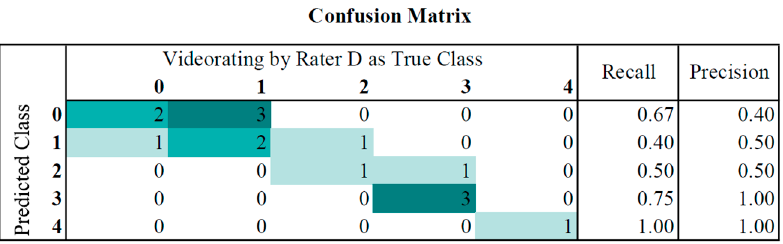
Figure 4. Confusion matrix of the implemented classification algorithm compared to predefined classes. Sensors 2016 , 16 , 930